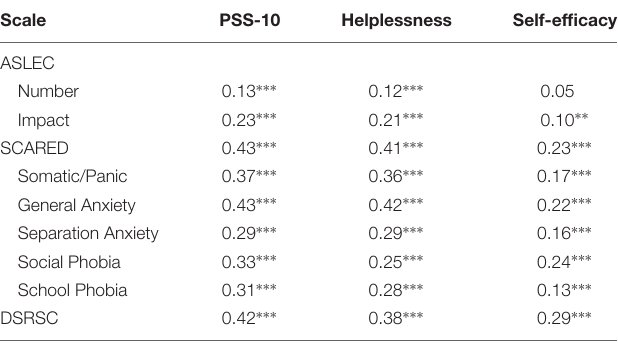
TABLE 3 | Pearson correlation coefficients between the PSS-10 and other measures.